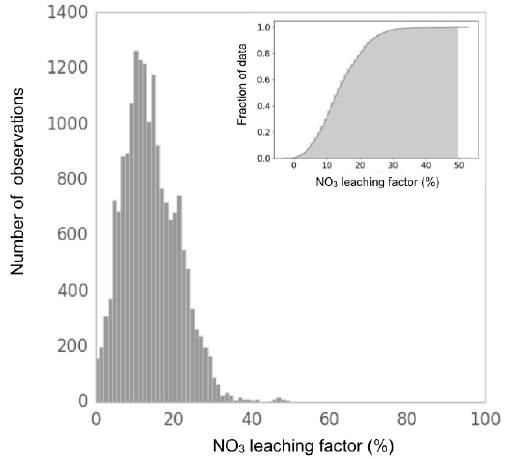
Figure 7. The distribution and cumulative distribution (small graph) of simulated NO 3 LFs.